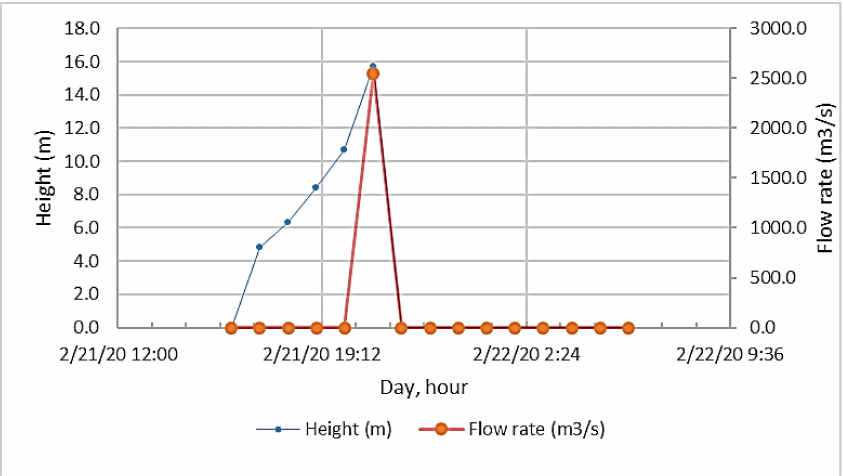
Figure 33. Hydrograph of entry to the Paso Camiara informal embankment.